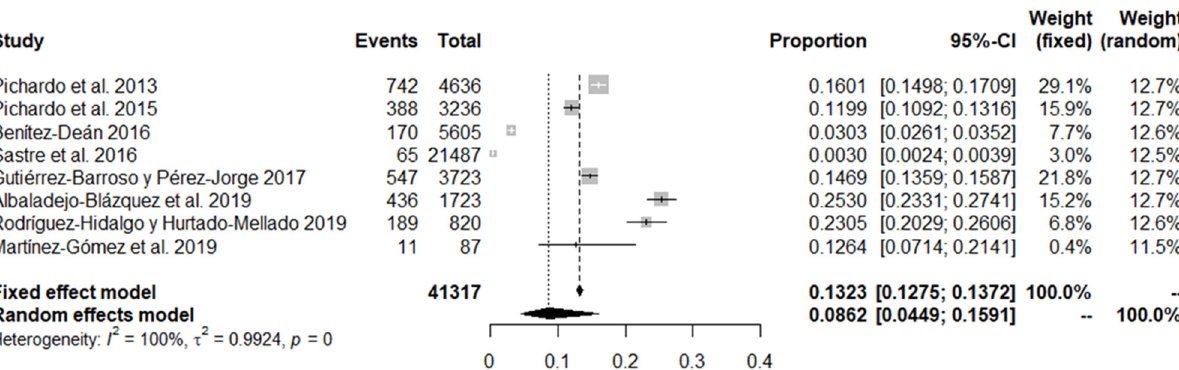
Figure 4. Forest plot of bullying victimisation among general population studies.